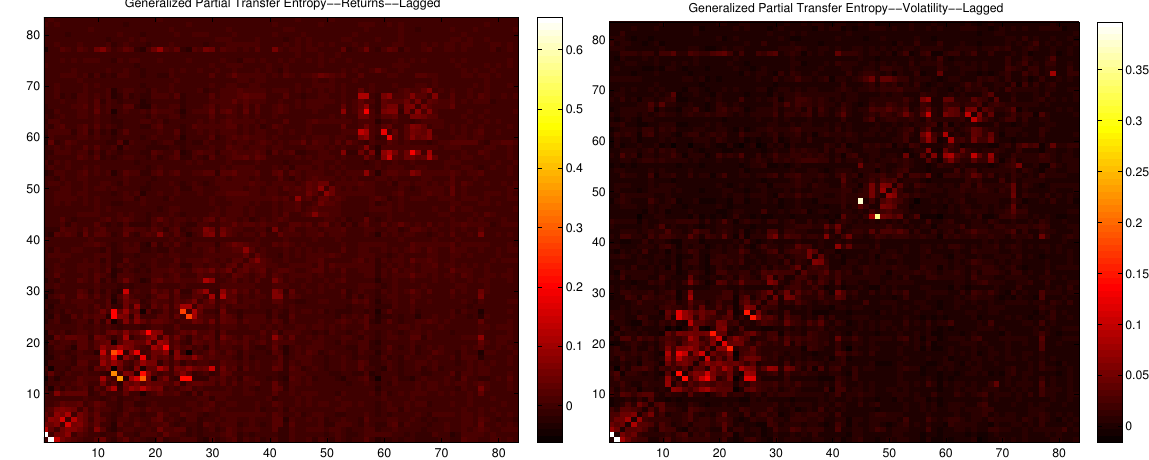
Figure 27. Generalized partial Tranfer Entropy of the log-returns ( left ) and of the volatilities ( right ), from lagged to original